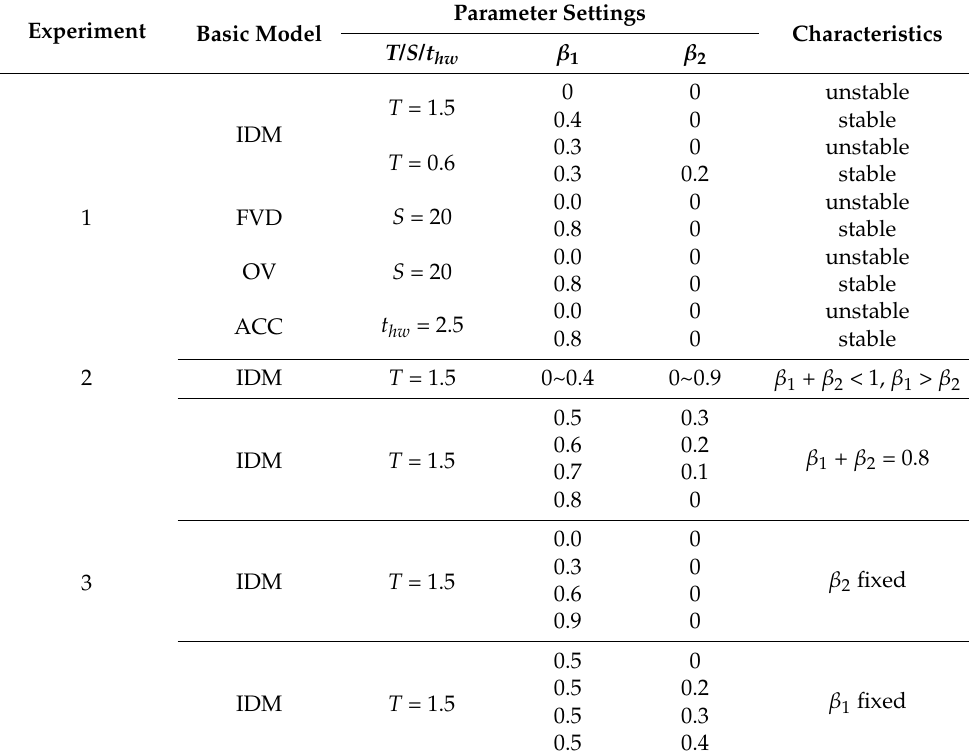
Table 2. The introduction of the experiments and their parameter